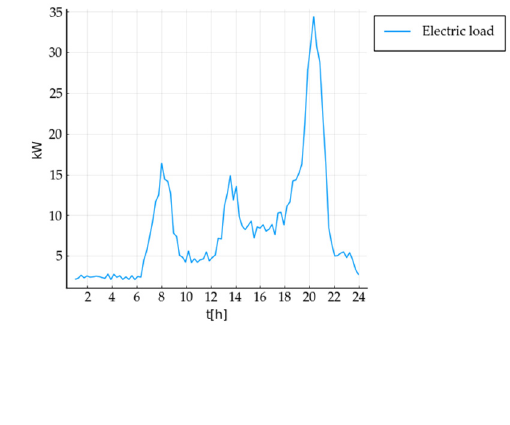
Figure 5. Daily evolution of the dwelling consumptions for a typical cold winter day: ( a ) electricity consumption; ( b ) thermal consumption.